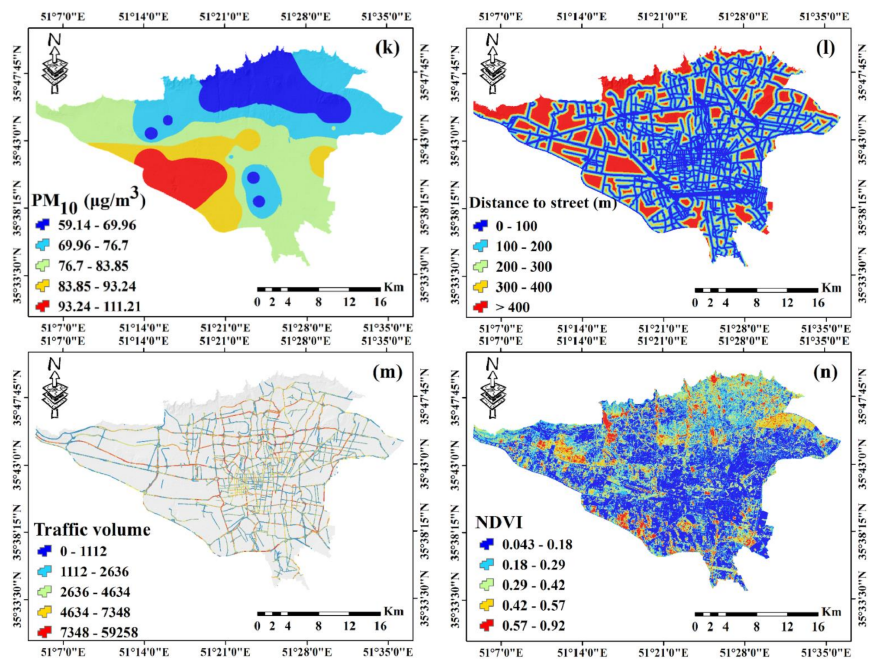
Figure 3. Independent factor maps: ( a ) altitude, ( b ) rainfall, ( c ) temperature, ( d ) humidity, ( e ) wind speed, ( f ) CO, ( g ) NO 2 , ( h ) O 3 , ( i ) SO 2 , ( j ) PM2 .5 , ( k ) PM 10 , ( l ) distance to street, ( m ) traffic volume, and ( n )